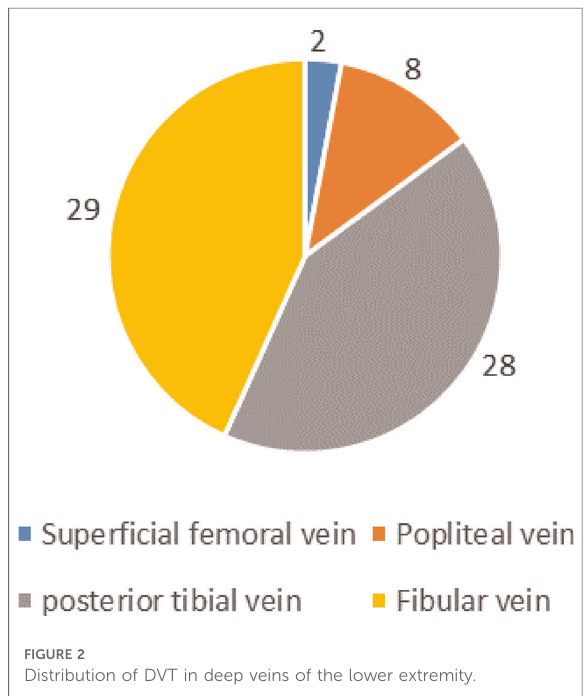
FIGURE 2 Distribution of DVT in deep veins of the lower extremity.